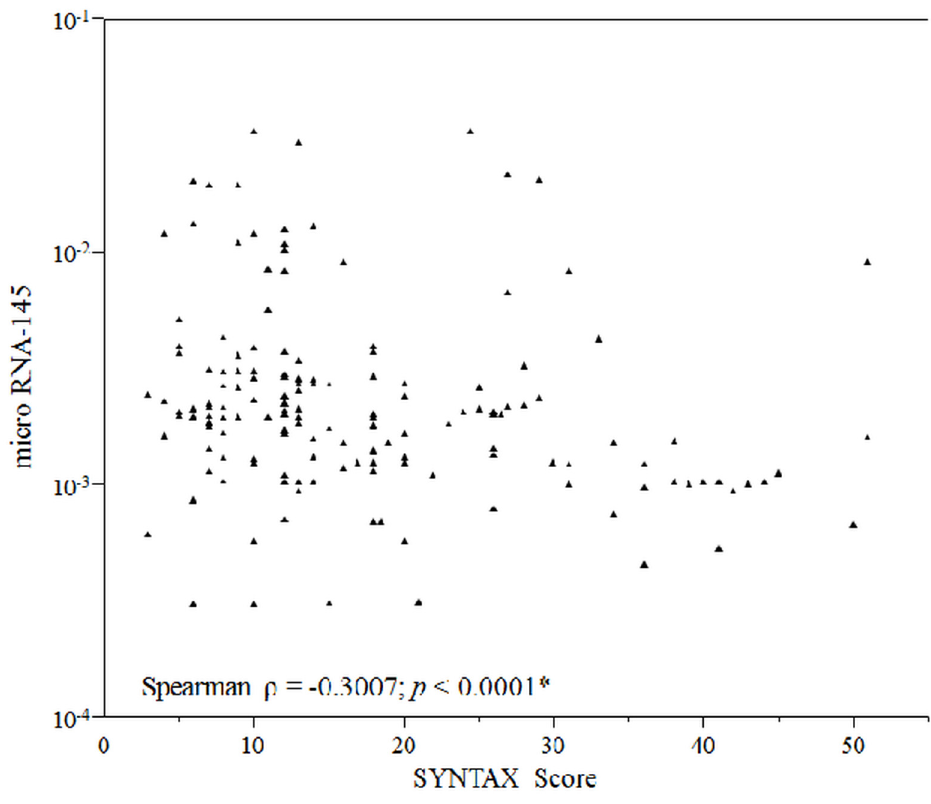
Fig 3. Correlation between SYNTAX score and plasma miRNA-145. The above scatter diagram demonstrates correlation between miRNA-145 and SYNTAX score. It can be noted that increase in SYNTAX score (increase in severity and complexity of CAD) is significantly correlated with reduced plasma miRNA- 145 levels. * p < 0.05; CAD, Coronary artery disease; RNA, Ribonucleic acid; SYNTAX, Synergy between PCI With Taxus and Cardiac